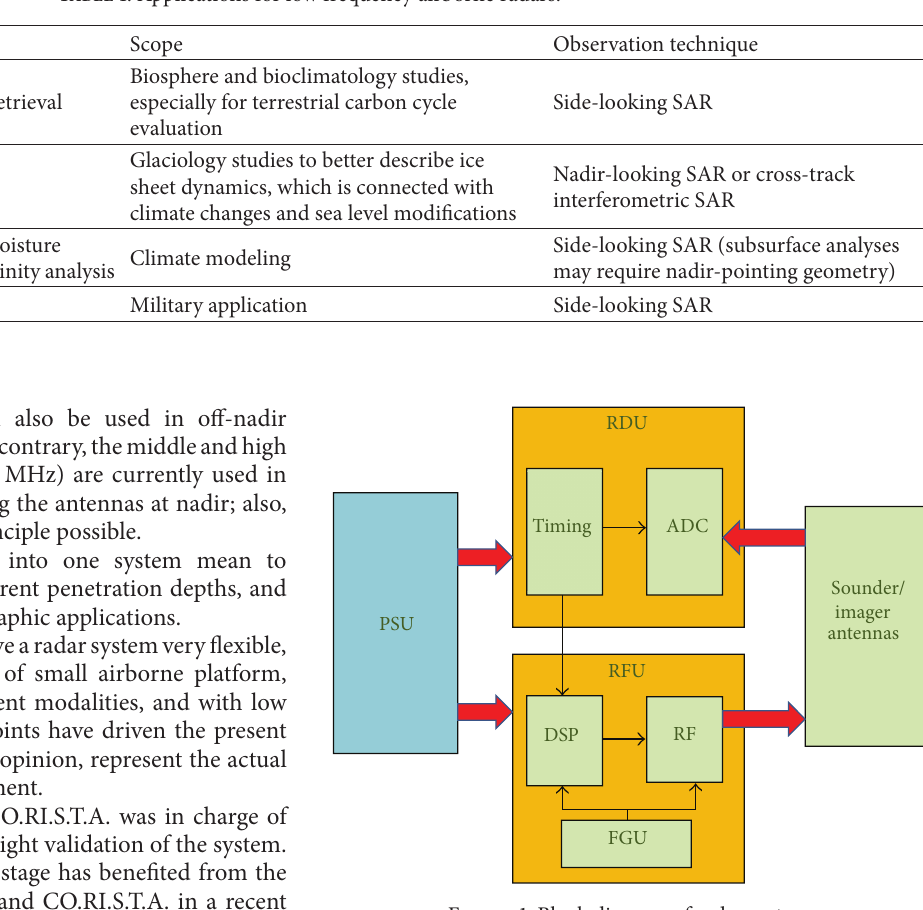
Figure 1: Block diagram of radar